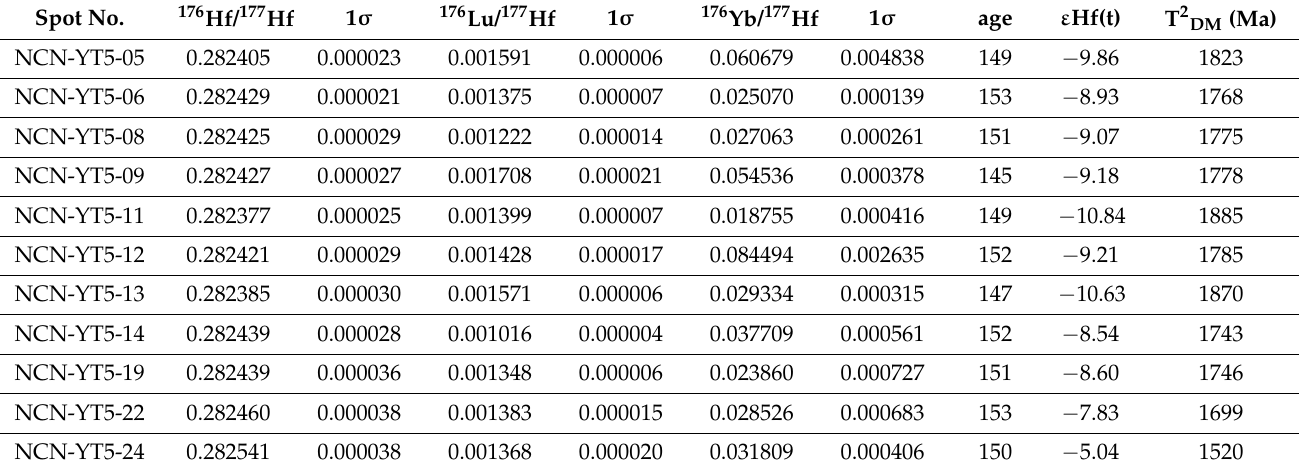
Table 2. Hf isotope analysis result of Nuocang granodiorite.